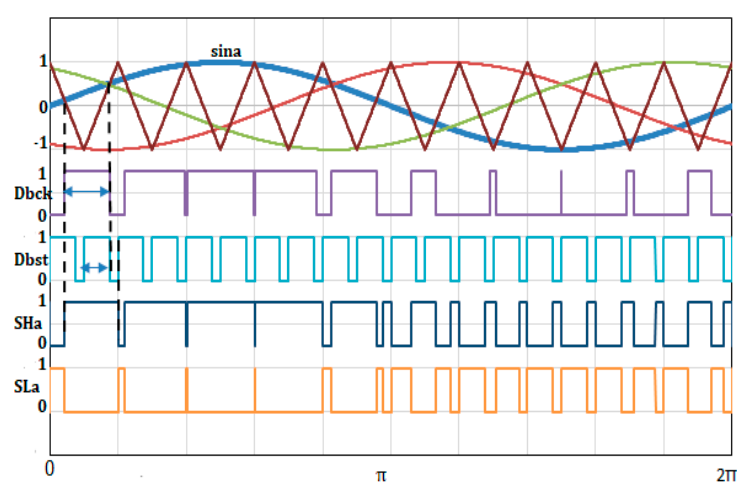
Figure 6. The switching pattern for the higher ( SH ) and lower ( SL ) switches and boost switch during one-line cycle.